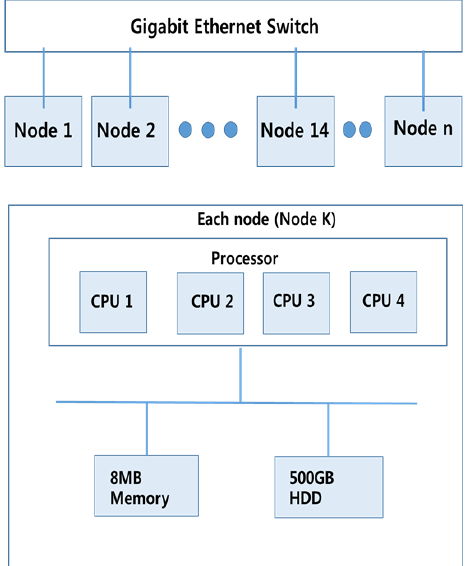
Figure 8. Flow chart of the object detection algorithm implemented for performance evaluation experiments.